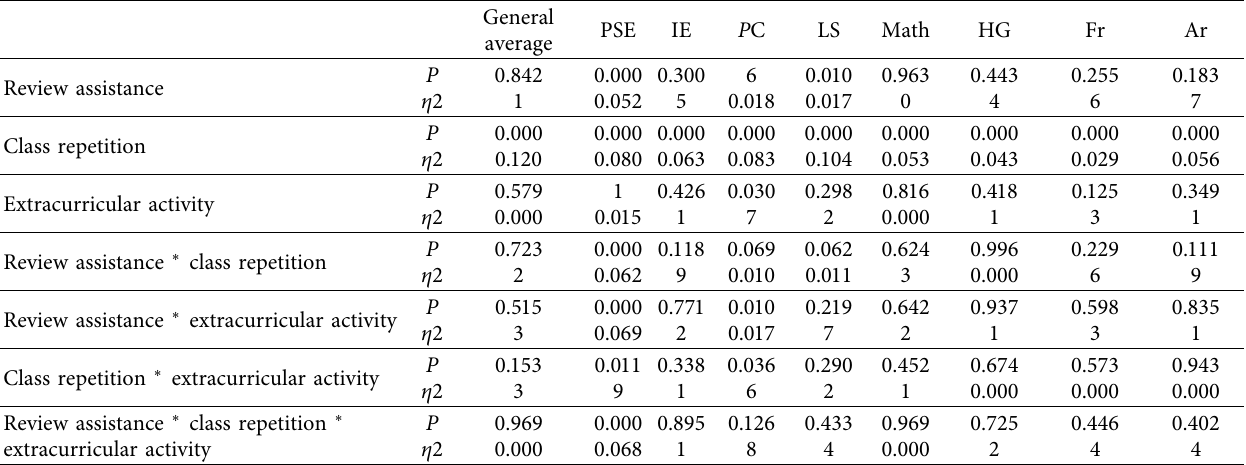
Table 9: Interaction of the effects of review assistance, class repetition, and extracurricular activity on academic achievement (MANOVA I, II, and